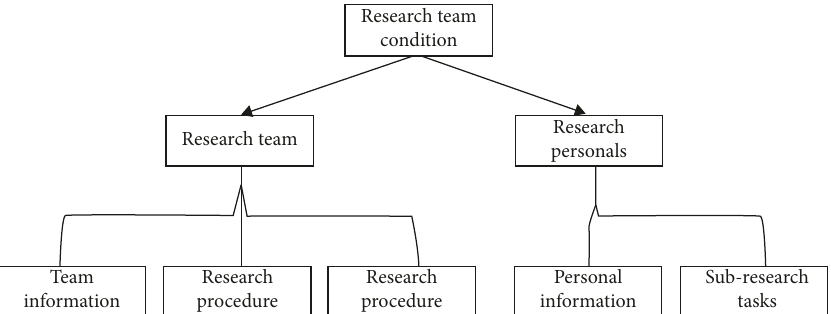
Figure 2: The illustration of the metadata produced by